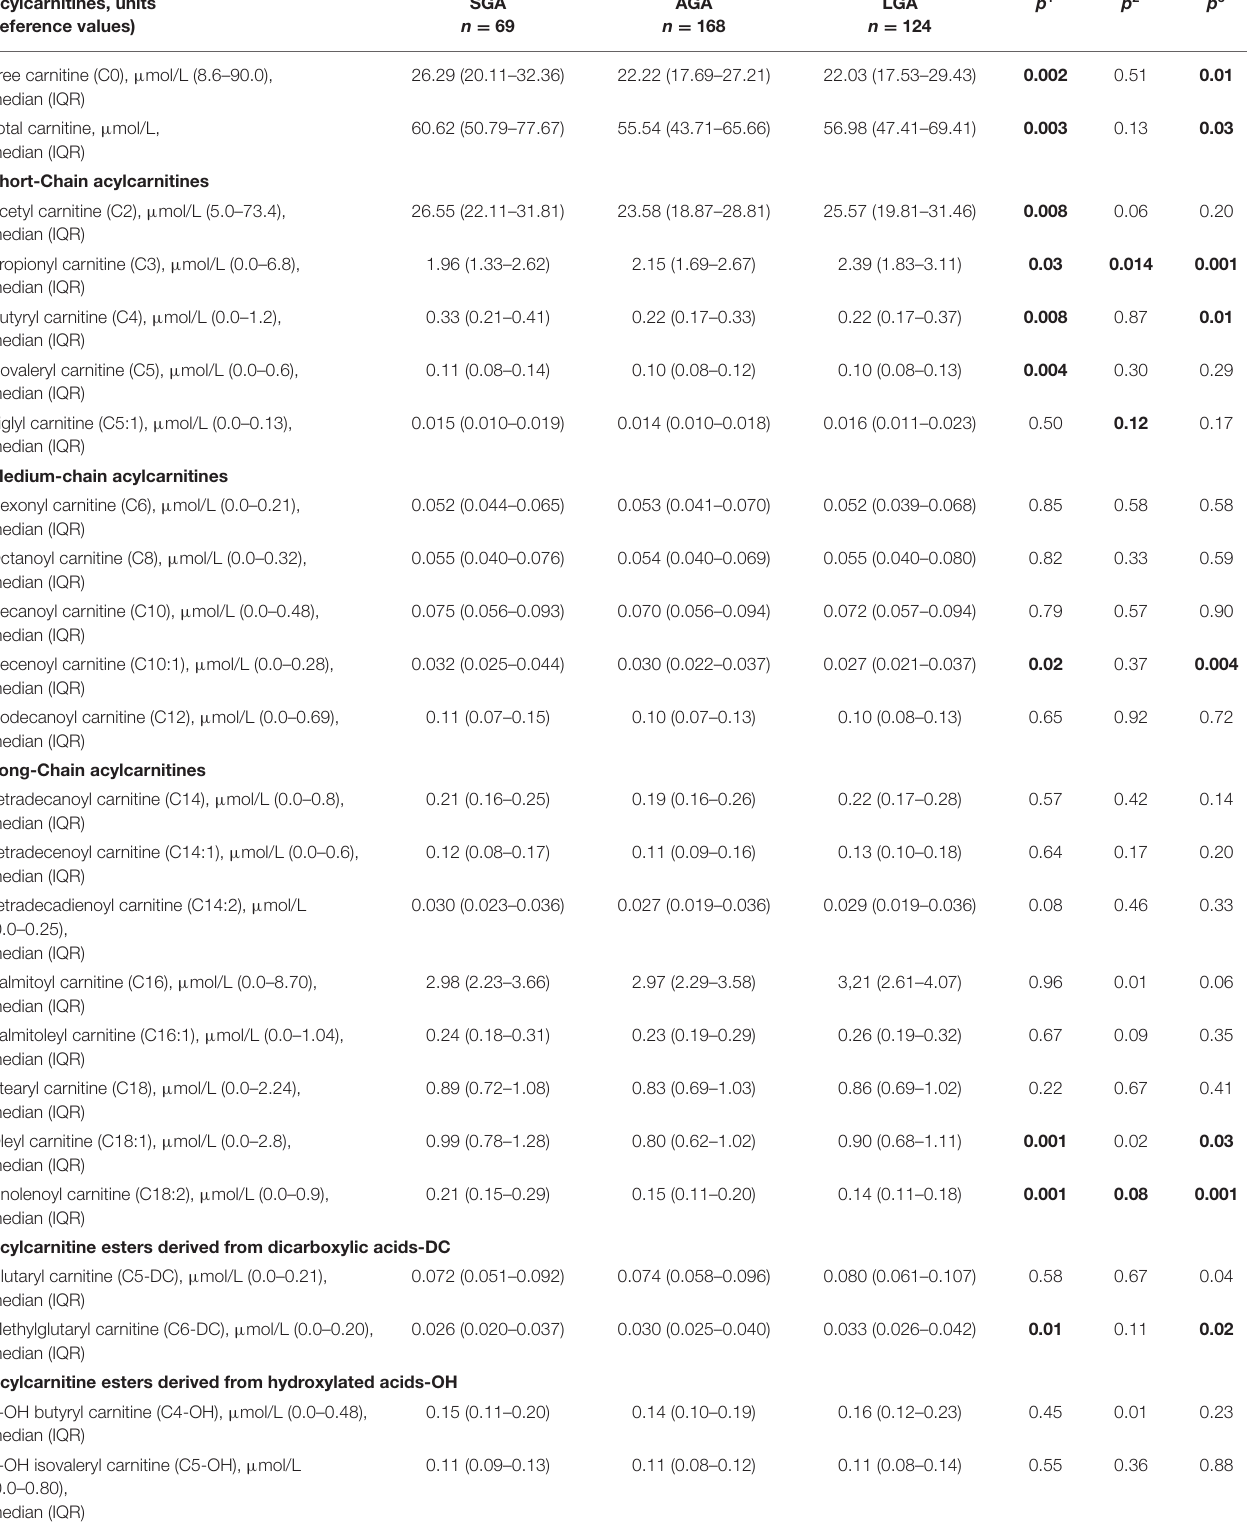
TABLE 3 | Levels of dried blood spot